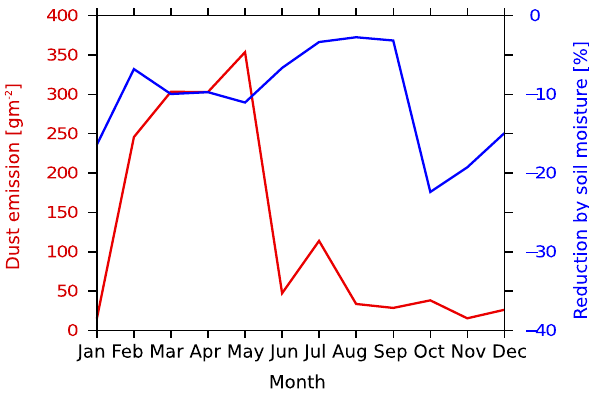
Figure 16. Dust emission amount associated with long-lived and migrating cyclones but weakened by soil moisture. Annual cycle of the total dust emission (red) and the fraction of dust emission sup- pressed by soil moisture in the cyclone-affected area (blue). Values are spatially integrated over the northern sub-domain (15 ◦ W–40 ◦ E and 20–40 ◦ N) and monthly averaged over